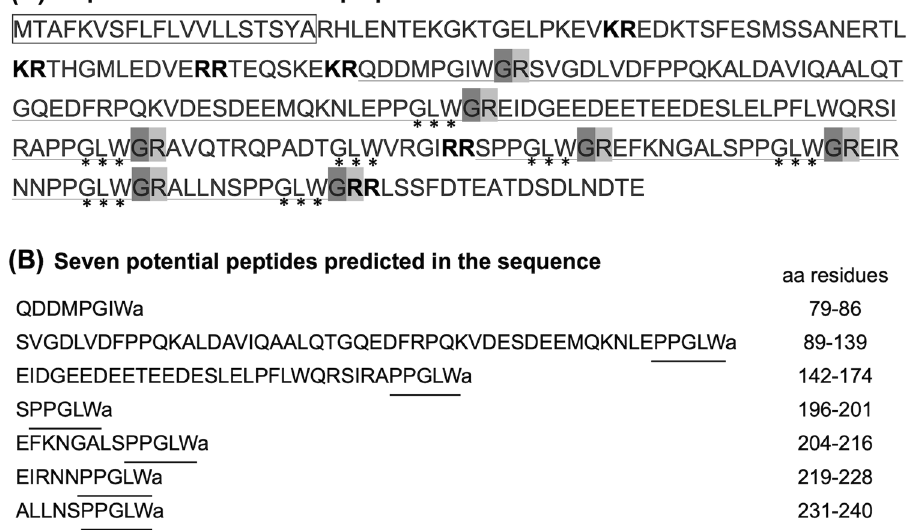
Figure 1. ( A ) Deduced amino acid sequence of EaGLWamide preprohormone. black box , predicted signal peptide. KR/RR , predicted dibasic cleavage sites; GR , C-terminal amidation with a monobasic cleavage site; underline , location of potential GLWamide peptide sequences; asterisk , GLW motif. ( B ) The seven potential peptides predicted from the EaGLWamide preprohormone using Peptraq software. The positions of the potential peptides in EaGLWamide preprohormone are shown on the right (aa residue). Note that all the potential GLWamide peptides contain a tandem proline residue followed by the GLW motif at the C-terminal end